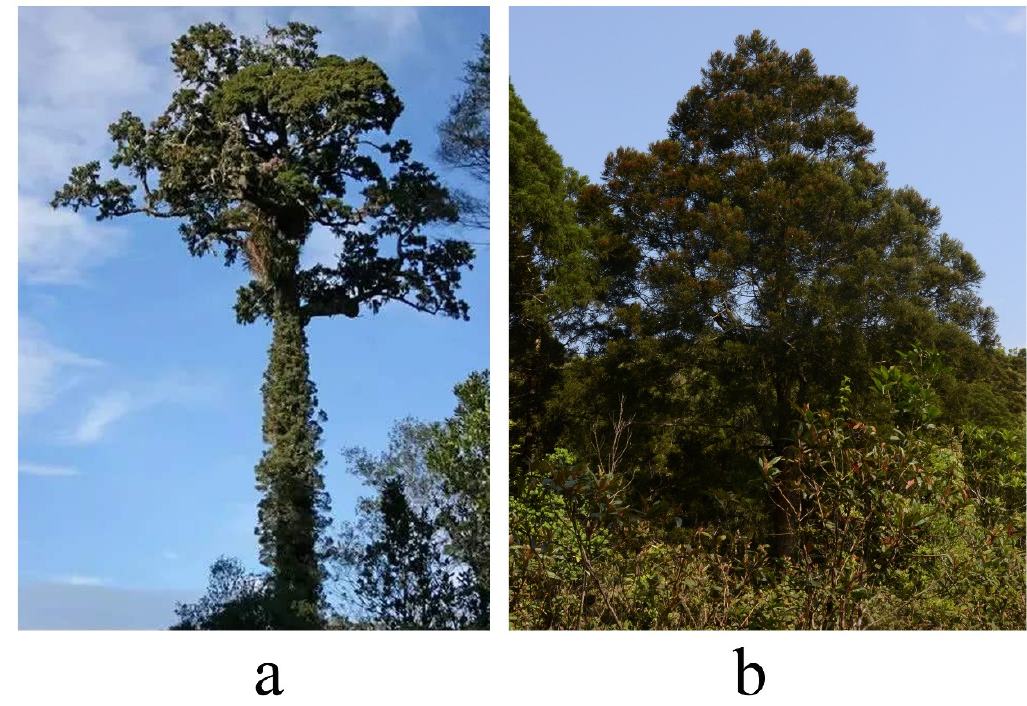
Figure 10. Photos of D. pierrei . ( a ) mushroom-shaped D. pierrei . ( b ) pagoda-shaped D. pierrei .